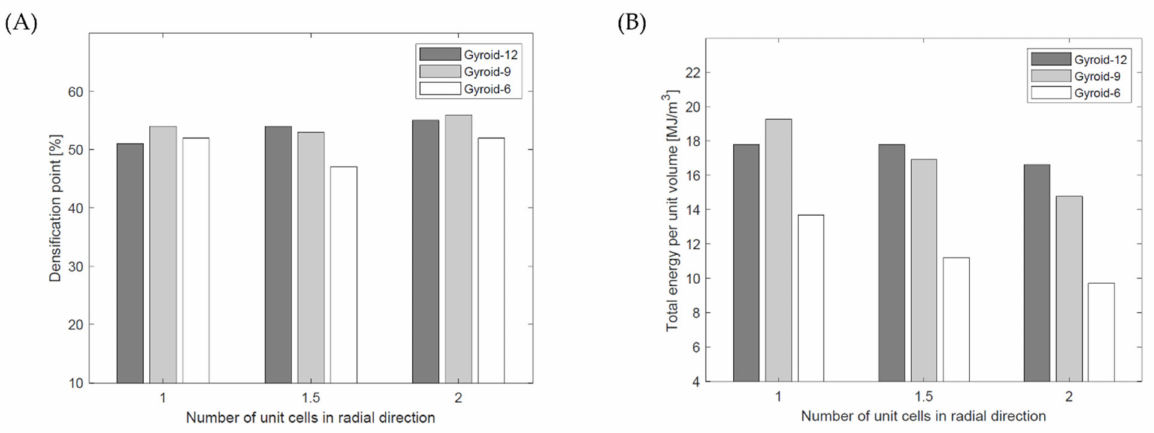
Figure 12. Densification point ( A ) and total energy absorbed per unit volume up to densification point ( B ) of tested cylindrical mapped gyroid structures.